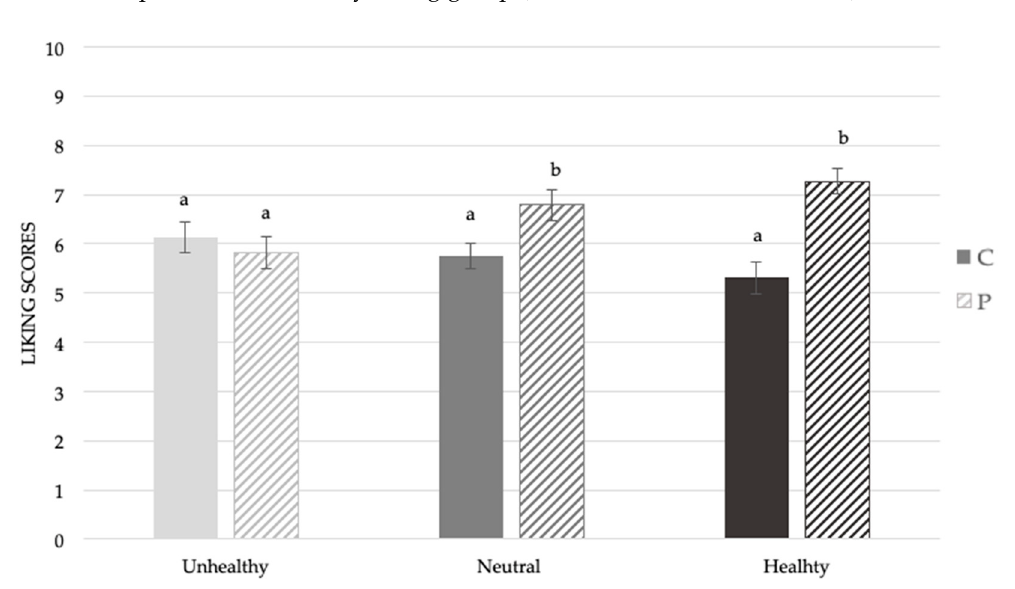
Figure 3. Mean liking scores ± SEM by samples according to food habits. Different letters indicate significant differences according to a post-hoc test for each sample.